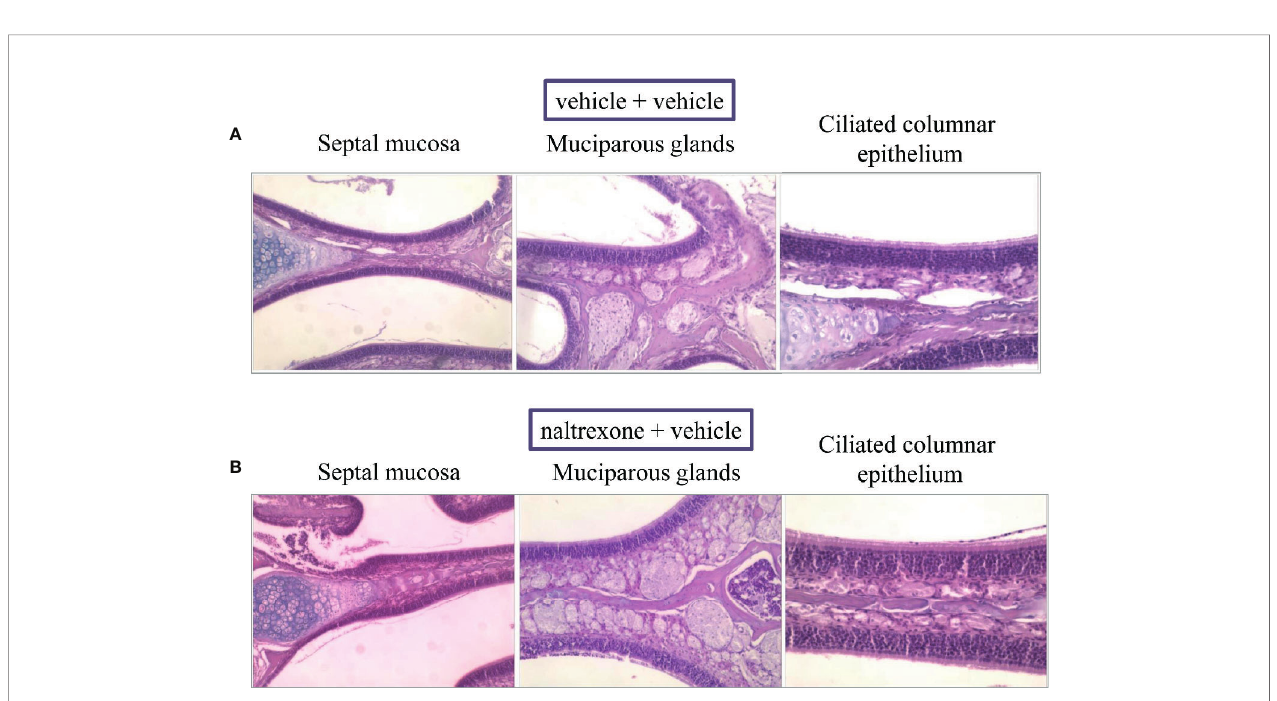
FIGURE 9 | Effect of intranasal administration of naltrexone on mouse nasal cavity. Histological analysis of hematoxylin-and-eosin (HE)-stained cross-sections of whole specimens taken from mice given nasal instillations of (A) vehicle or (B) naltrexone 24 h before. Septal mucosa, including ciliated surface epithelium, muciparous glands, and stroma, shows a normal appearance in both experimental groups that were analyzed. Images are representative of at least four animals from two independent